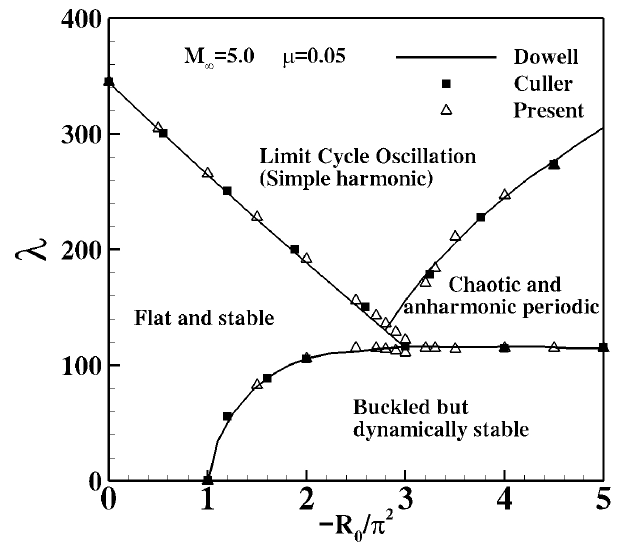
Figure 2. Stability regions.